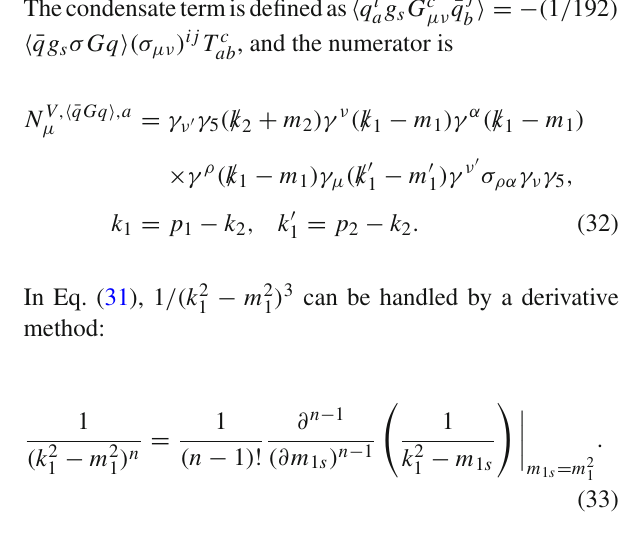
Fig. 6 Quark propagators in the QCD vaccum. x and y are spacetime coordinates, i and j are color indices, and p i , k and k i are momenta Thecondensatetermisdefinedas (cid:5) q i